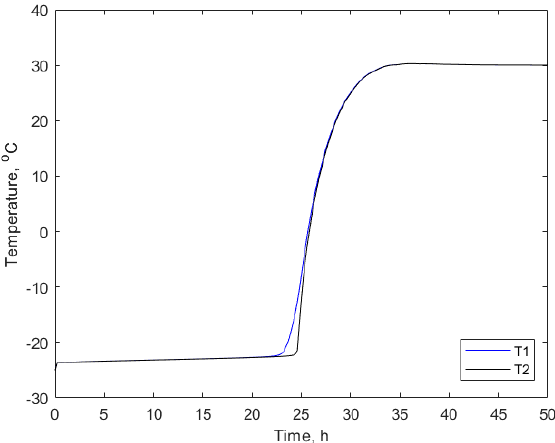
Figure 12. Distribution of temperature inside the refrigerated trailer over time ( a ) 0 h, ( b ) 24 h, ( c ) 25 h, and ( d ) 26 h.